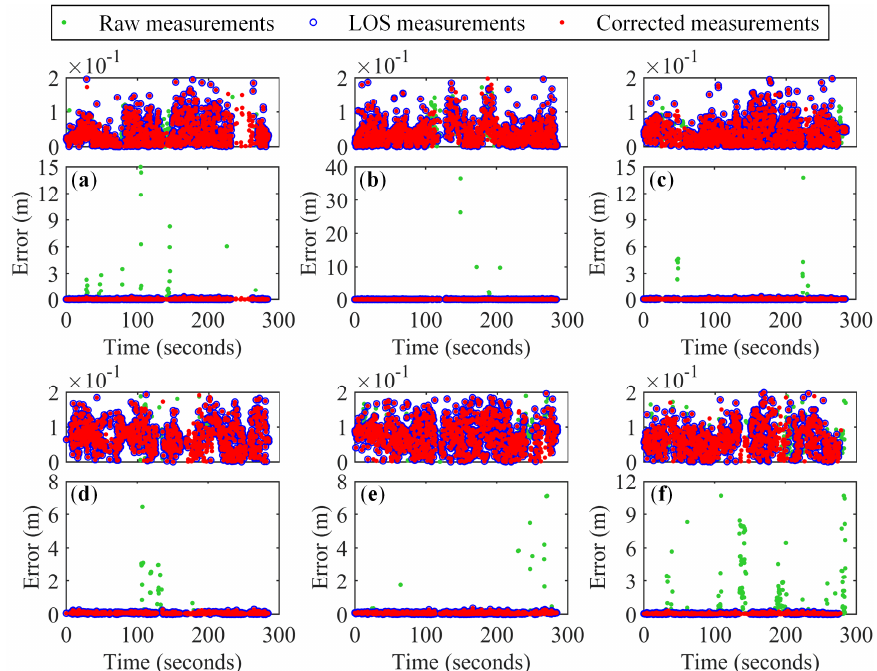
Figure 7. Time series of the reference measurements (black), UWB raw measurements (green), LOS measurements (blue) and corrected measurements (red) for different anchors: ( a ) anchor 1, ( b ) an- chor 2, ( c ) anchor 3, ( d ) anchor 4, ( e ) anchor 5, and ( f ) anchor 6.